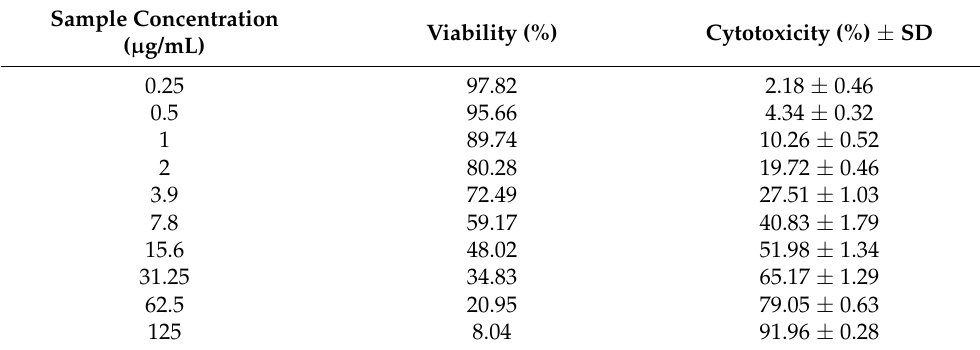
Table 3. Cytotoxic effect of clove essential oil against Vero cells (50% cell cytotoxic concentration CC 50 = 14.21 ± 0.67 µ g/mL). The outcomes are presented as the mean ± standard deviation (SD). Table 4. The antiviral efficiency of clove essential oil against the tested viruses.